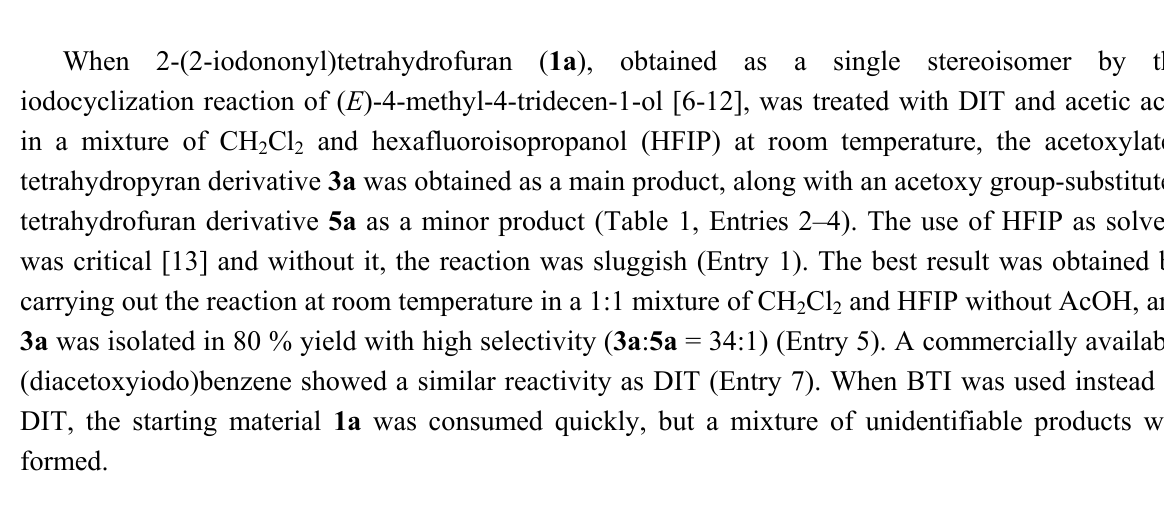
Table 1 . Ring-enlargement reaction of 1a using DIT